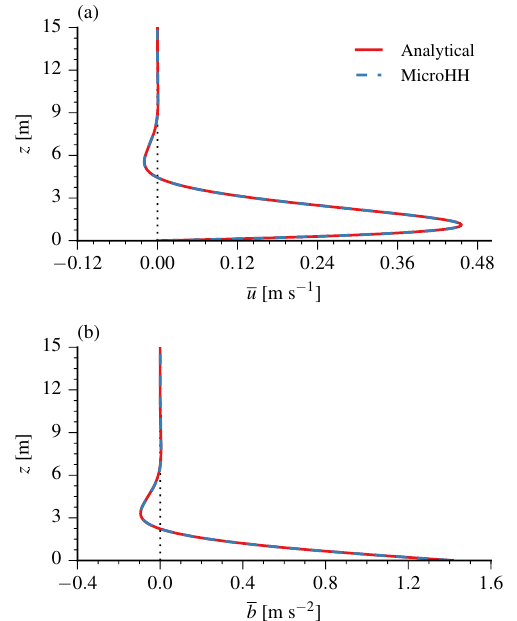
Figure 4. Normalized numerical Prandtl model solutions for veloc- ity u (a) and buoyancy b (b) compared to their analytical counter- parts.